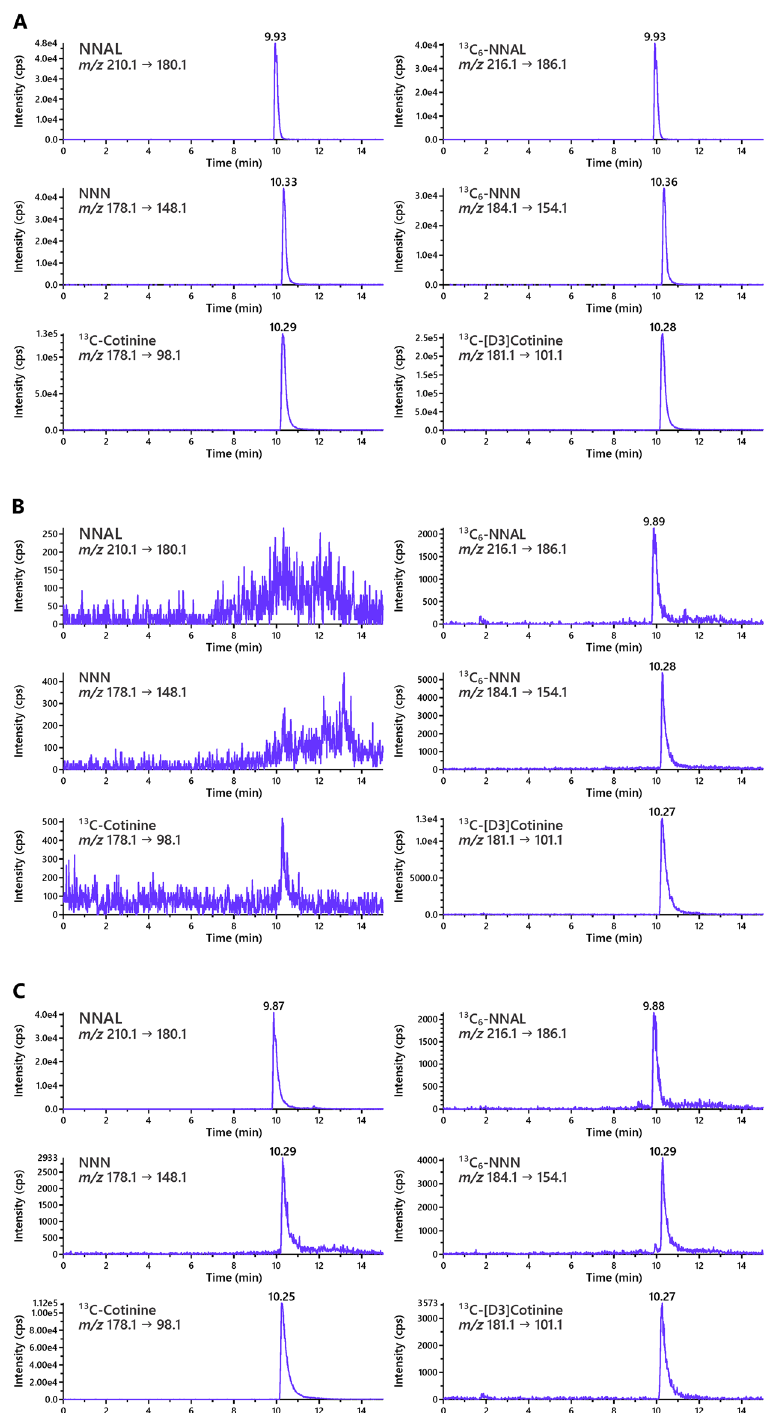
Figure 1. Representative LC–MS/MS chromatograms of NNAL, NNN and cotinine (left panel) and their respective internal standards (right panel) in ( A ) standard mix; ( B ) urine sample from a non-user of tobacco; and ( C ) urine sample from an SLT